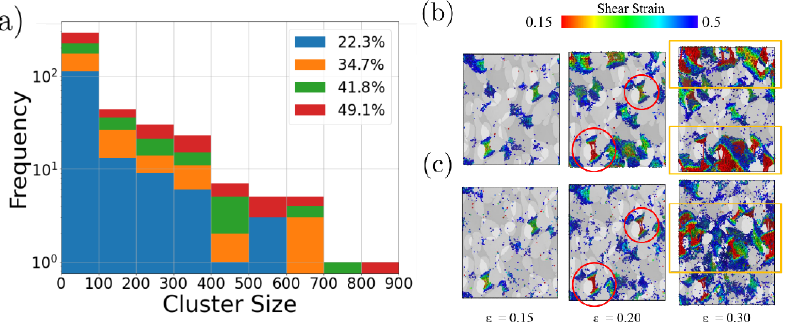
Figure 8. ( a ) Histograms showing the number of clusters of atoms with shear strain larger than 0.15. The shear strain of a half-cut of the nanoporous aC with ( b ) sp 3 = 22.3% and ( c ) sp 3 = 49.1% at different strains. Atoms are colored according to shear strain. Atoms with shear lower than 0.15 were removed from the figure and not considered in the cluster count. Red circles illustrate the breaking of some filaments at strains of 0.15. Orange regions show the formation of cracks at strains of